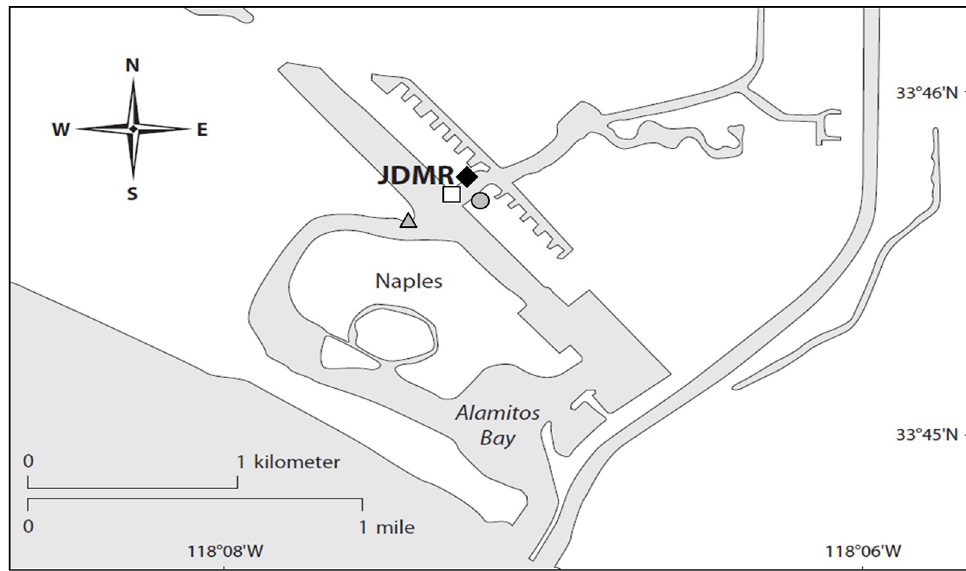
Fig 2. Site locations in Alamitos Bay, Long Beach, California, USA. Impact ( ◆ ) and control location ( □ ) within Jack Dunster Marine Reserve (JDMR) in relation to reference eelgrass beds 1 (grey circle) and 2 (grey